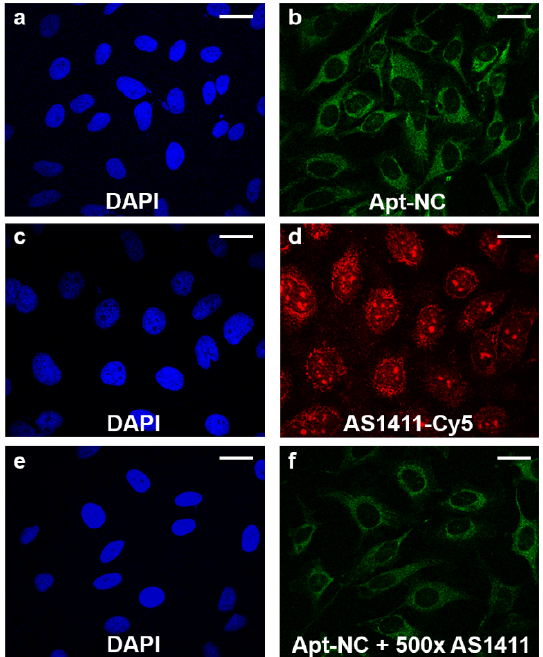
Figure 4. Comparison of intracellular distribution of Apt-NCs and Cy5-AS1411. Cells were incubated with 60 nM biotinylated Apt-NCs (panels a , b ) or 3 µ M free Cy5-AS1411 (panels c , d ) for 1 h at 37 °C. (panels e , f ) show cells incubated with Apt-NCs in the presence of 500 molar excess of free AS1411. Biotinylated Apt-NCs were visualized using streptavidin–FITC, and nuclei were stained with DAPI. Scale bar: 20 μ m.